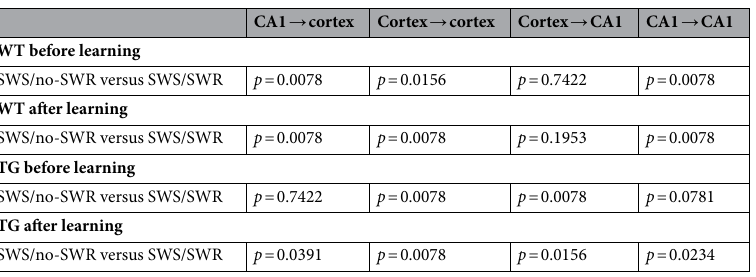
Table 1. Comparison of connectivity strength expressed during SWS/no-SWR and